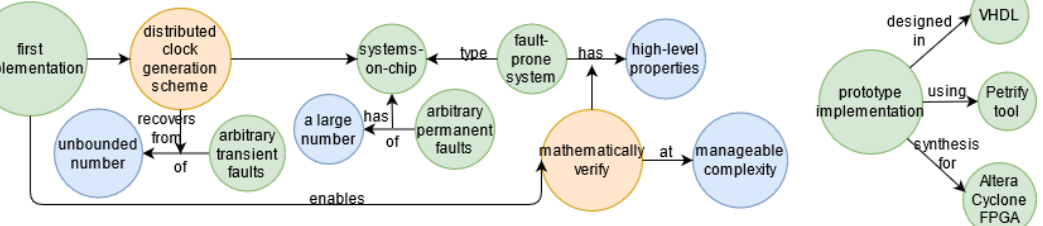
Figure A7. Structured KG representation of a Computer Science domain publication Abstract [71] as process, method, material, and data typed